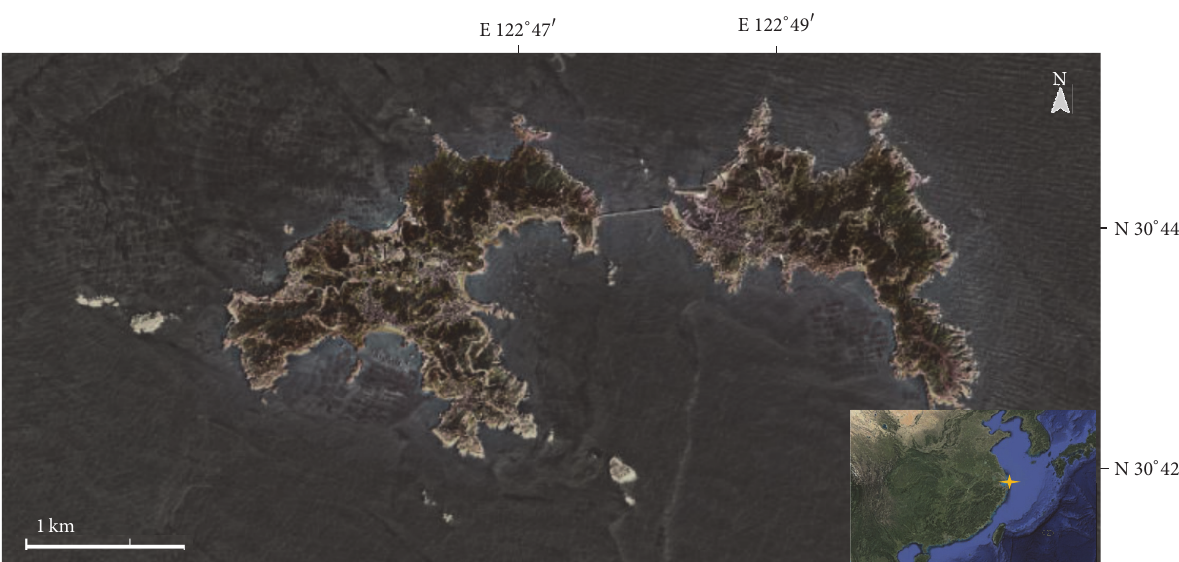
Figure 1: The map of Gouqi Island and its location in East China.